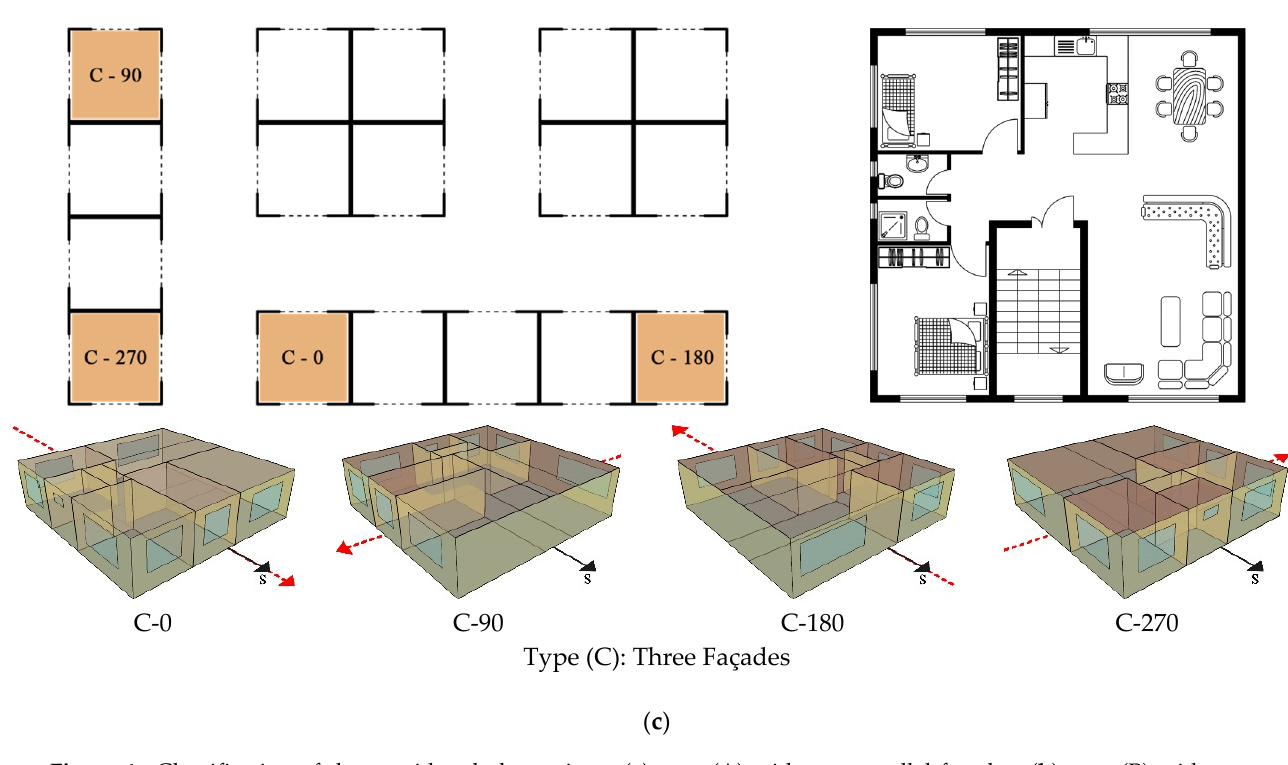
Figure 4. Classification of the considered alternatives: ( a ) type (A) with two parallel façades; ( b ) type (B) with two perpendicular façades; ( c ) type (C) with three façades.